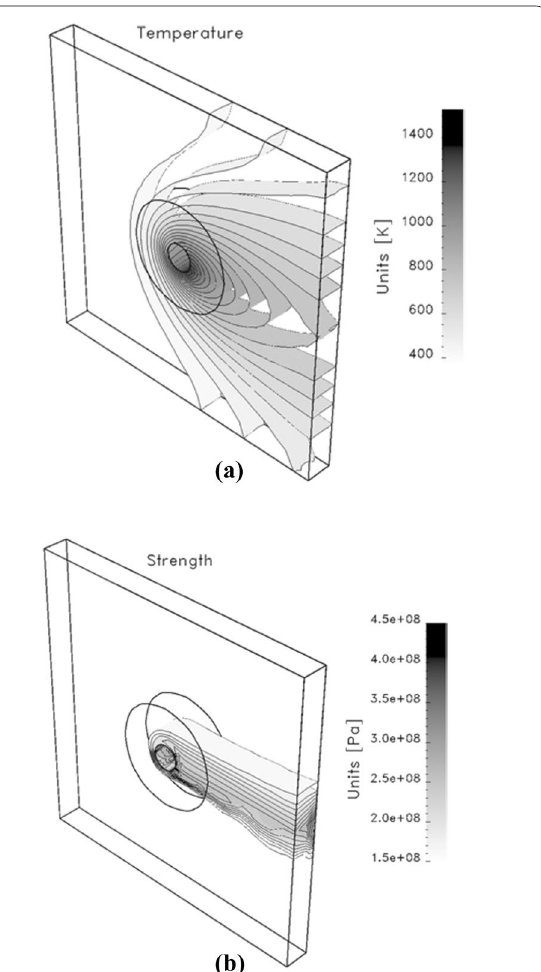
Figure 41 Distribution of the temperature and the strength during the welding: ( a ) temperature distribution, ( b ) strength